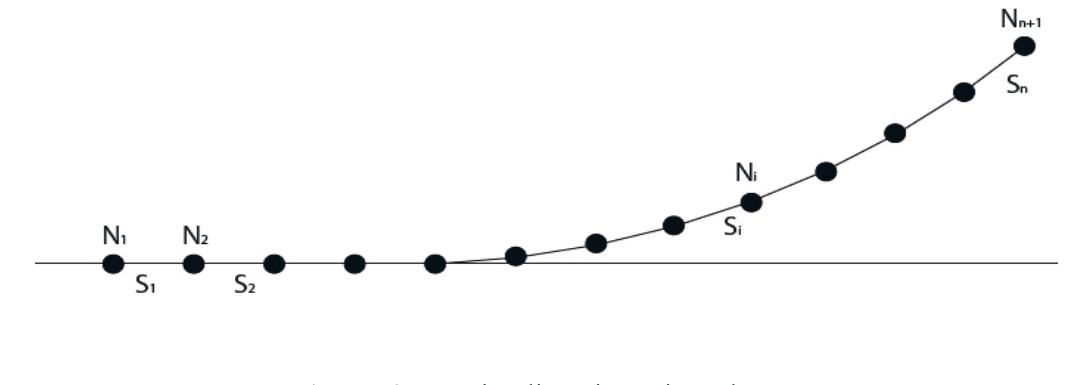
Figure 6. Mooring line piecewise